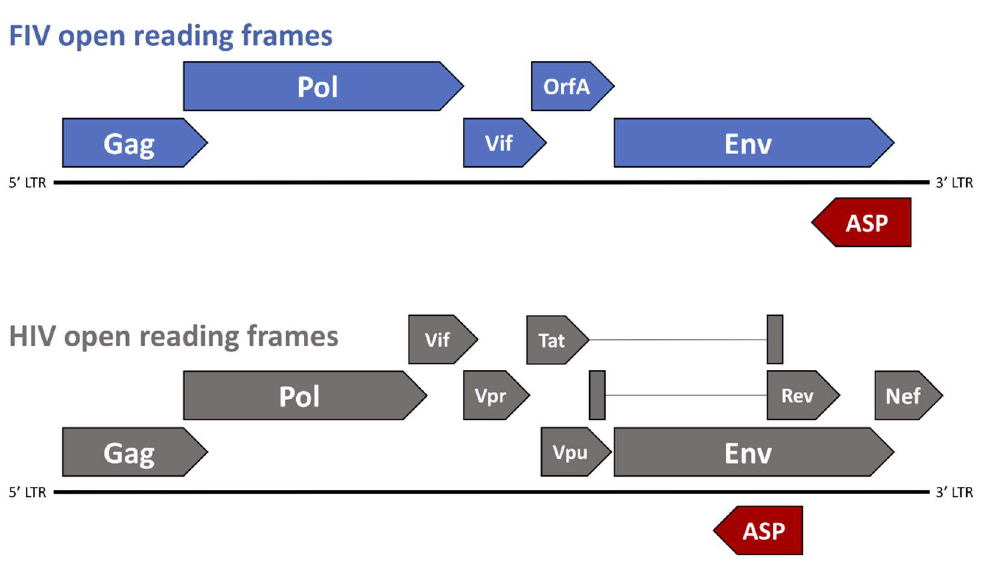
Figure 2. Genomic organization of FIV and human immunodeficiency virus (HIV). The genomic structure of FIV consists of three primary open reading frames (ORFs), gag , pol , and env , which are flanked by two long-terminal repeats (LTR) and accompanied by numerous small ORFs containing regulatory and accessory genes such as vif and orfA. Potential short ORFs (antisense ORFs—ASP, shown in red) may be translated from a negative strand message. The genomic structure of HIV consists of three similar primary ORFs ( gag , pol , and env ), as well as numerous small ORFs containing regulatory and accessory genes, such as vif , vpr , vpu , tat , rev , and nef. Similar to FIV, the antisense ORF, ASP (shown in red) may be translated from a negative strand message.